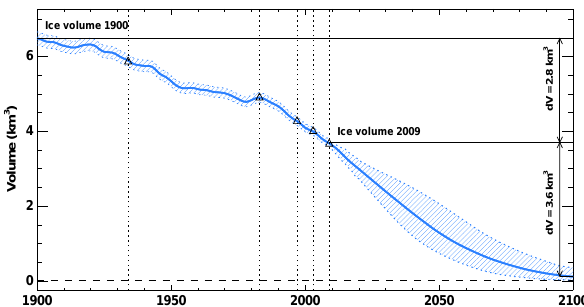
Fig. 5. Ice volume evolution in the Mauvoisin region between 1900 and 2100. The hatched zone represents the 95% confidence interval for the past given by the ice volume uncertainty and for the future given by the 100 different model runs. Black triangles and corre- sponding dotted lines show years in which a DEM is available. Fig. 6. Projected glacier retreat in the Mauvoisin region until the end of the 21st century. Glacier area is shown in 10-yr steps. Hatched zones framed by grey thick lines represent the outlines of the two subcatchments Mauvoisin and Corbassi`ere/Petit